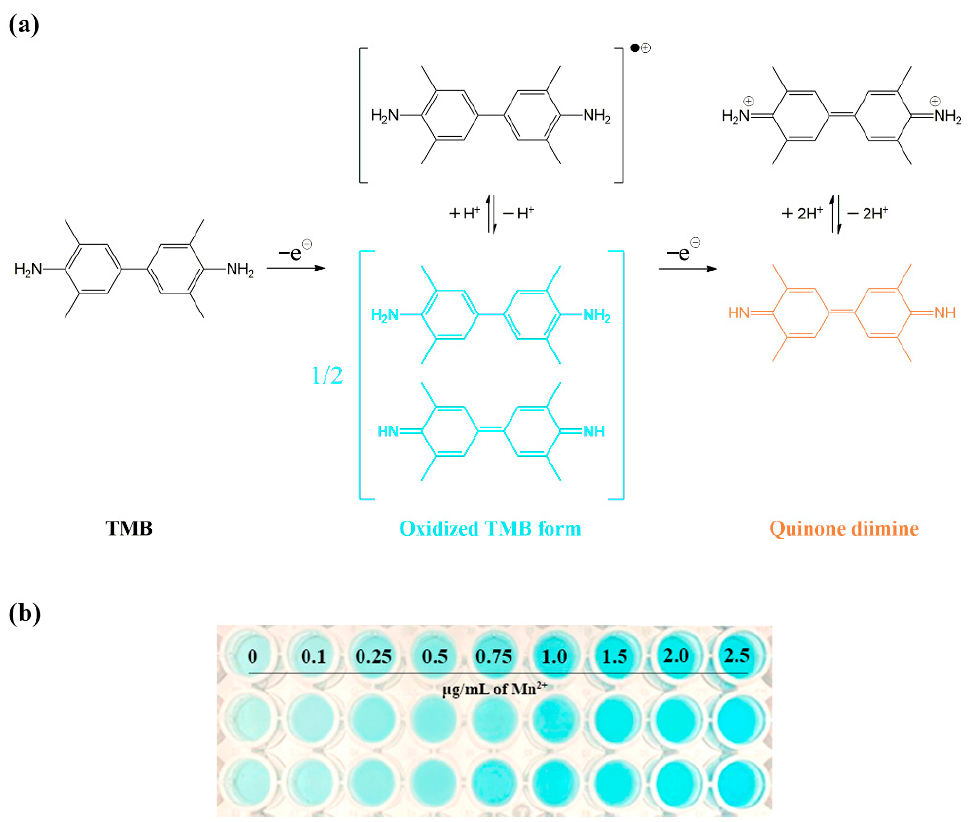
Figure 1. Oxidation of TMB by periodate using manganese (Mn(II)) as a catalyst: ( a ) the mechanism illustration and ( b ) the bluish-green products (oxidized TMB form) produced by being catalyzed with various Mn(II) concentrations (reaction condition: 2.08 mM TMB, 4.3 mM KIO 4 , phosphate buffer pH 6).